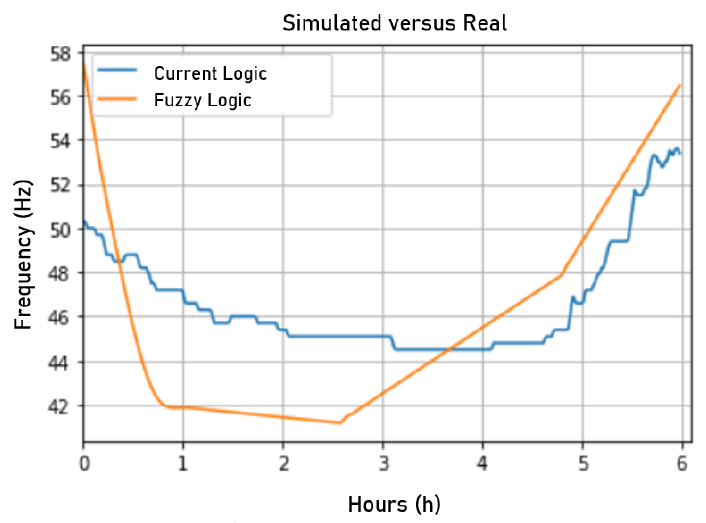
Figure 25. Comparison between simulated and actual fuzzy rotational frequencies. Source: